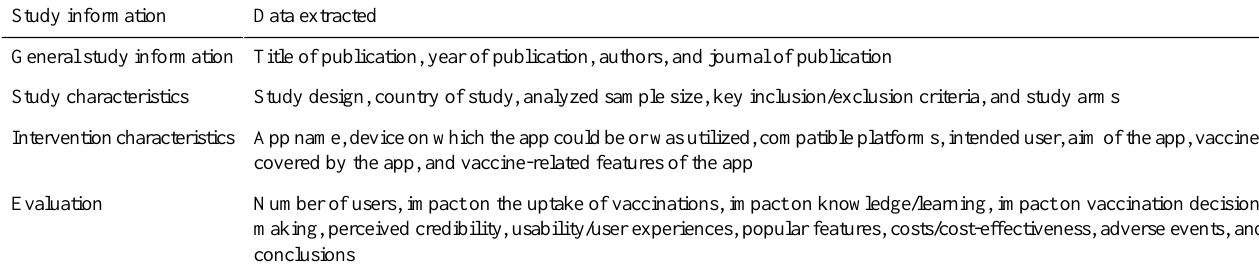
Table 1. Data extracted from the included